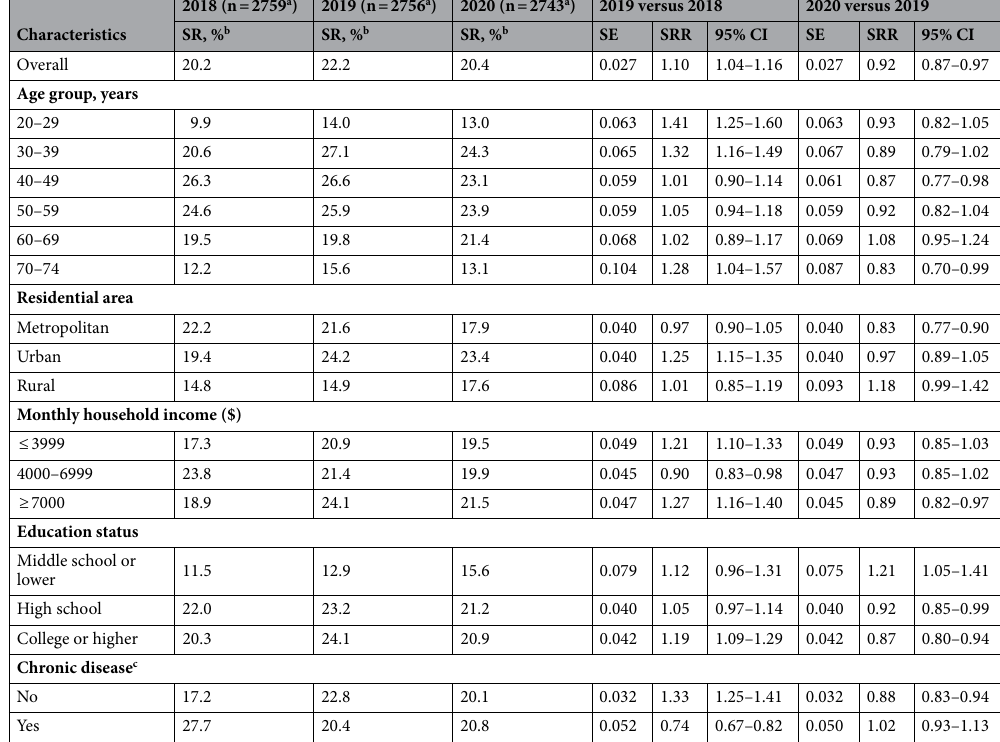
Table 4. Cervical cancer screening rates for the period 2018–2020. SR screening rate, SRR screening rate ratio, SE standard error, CI confidence interval. a The n value is the number of women eligible for cervical cancer screening (aged over 20 years); b SRs were defined as the proportion of screened women within the last 1 year; Weighting values from the Population and Housing Census were applied to calculate the SRs; c Chronic disease, women who are diagnosed with any of following diseases: hypertension, diabetes, tuberculosis, hepatitis B, hepatitis C, liver cirrhosis, chronic gastritis, stomach/duodenal ulcers, polyps, benign breast diseases, uterine myoma, and